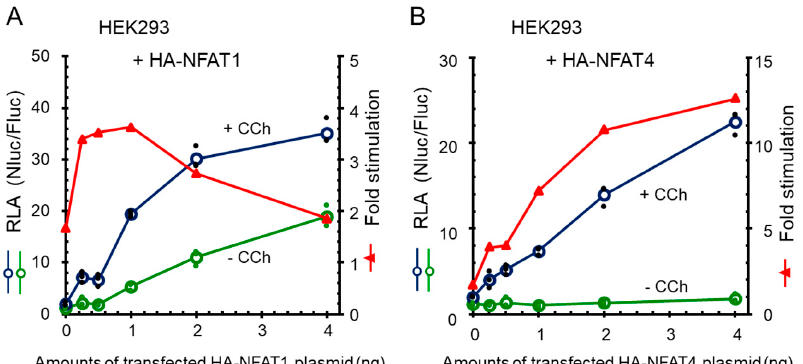
Figure 8. Greater carbachol-dependent reporter activity by NFAT4 than by NFAT1. HEK293 cells were transfected with various amounts of HA-tagged NFAT expression plasmids (0–4 ng) for ( A ) NFAT1 or ( B ) NFAT4. Empty vector was supplemented to equalize the total amounts of pCMV-3×HA-A vector and its derivatives (4 ng). Cells were stimulated with carbachol (+CCh, 100 μ M) or unstimulated ( − CCh) for 6 h before luciferase assays. Small dots and unfilled circles represent individual and averaged RLA values obtained from triplicate assays, respectively. Ratio of RLA values obtained in the presence and absence of carbachol [RLA(+CCh)/RLA( − CCh) ] was calculated and expressed as fold stimulation (red line graphs).